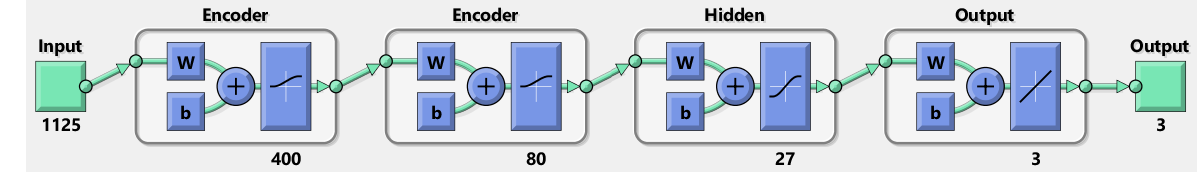
Figure 5. The proposed SAE topology for the semantic segmentation of buildings over multiple channel orthoimages. The initial image is separated into overlapping blocks of size 15 × 15 × 5 = 1125 .